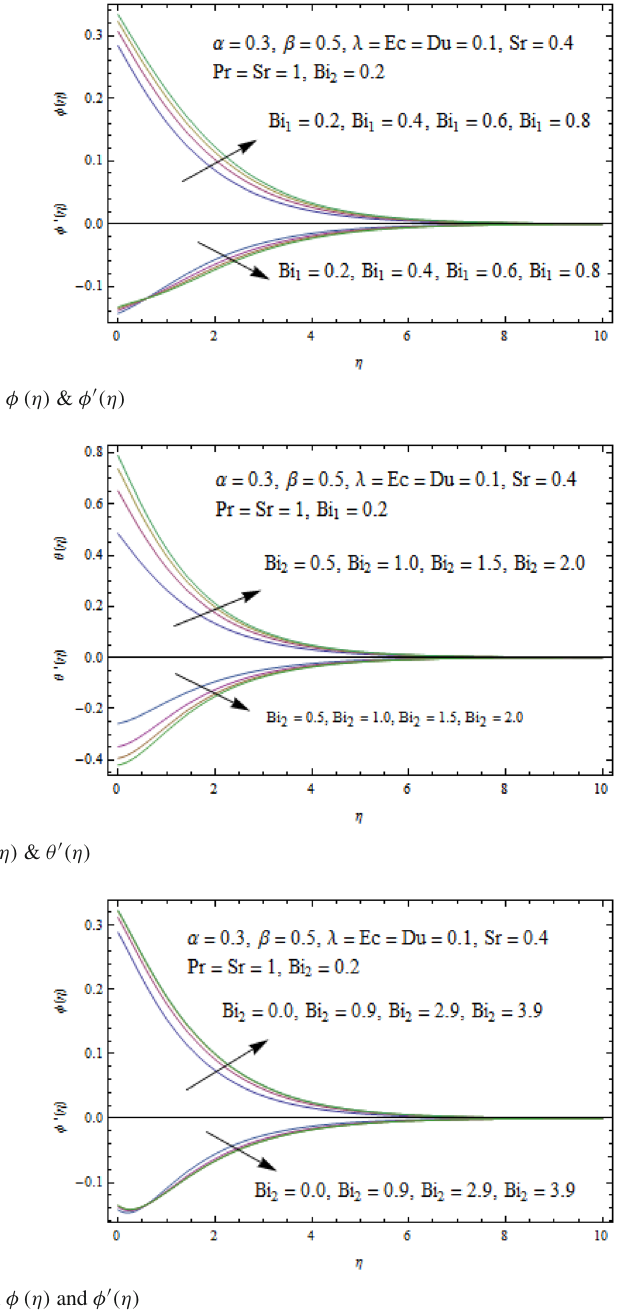
Fig. 18 Impact of Bi 2 on φ (η) and φ (cid:5)